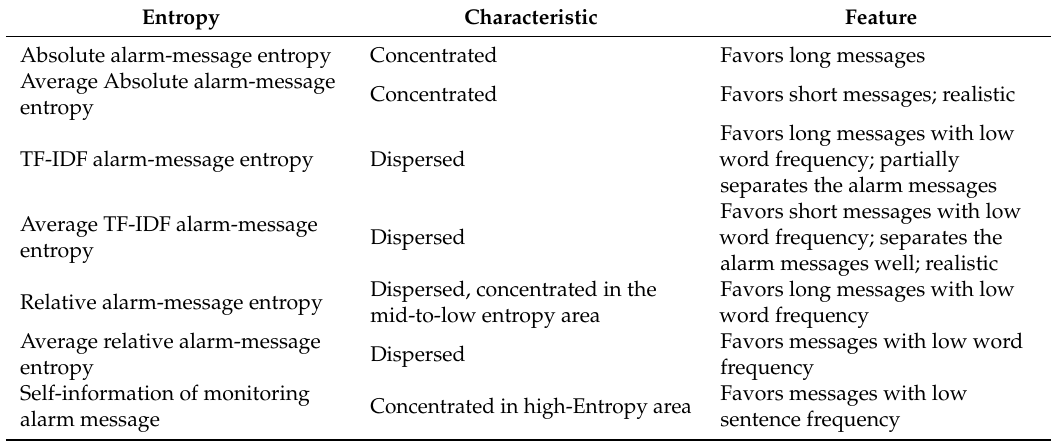
Table 3. Summary of the characteristic and feature of each alarm-message entropy mentioned above.